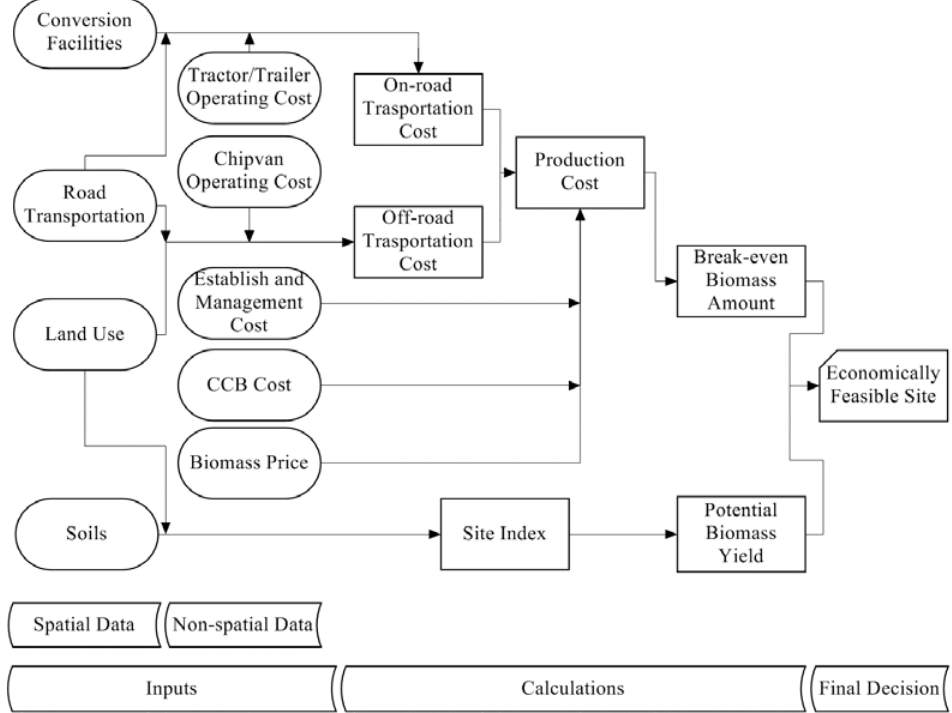
Figure 1. Diagram illustrating the general structure of the spatially-explicit model to identify economically feasible site to establish bioenergy crops. (CCB cost indicates the cost of cutting, chipping, and blowing